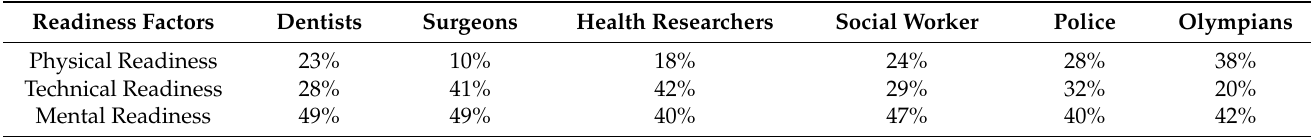
Table 2. Interdisciplinary Comparison of the Importance of Readiness for Performance